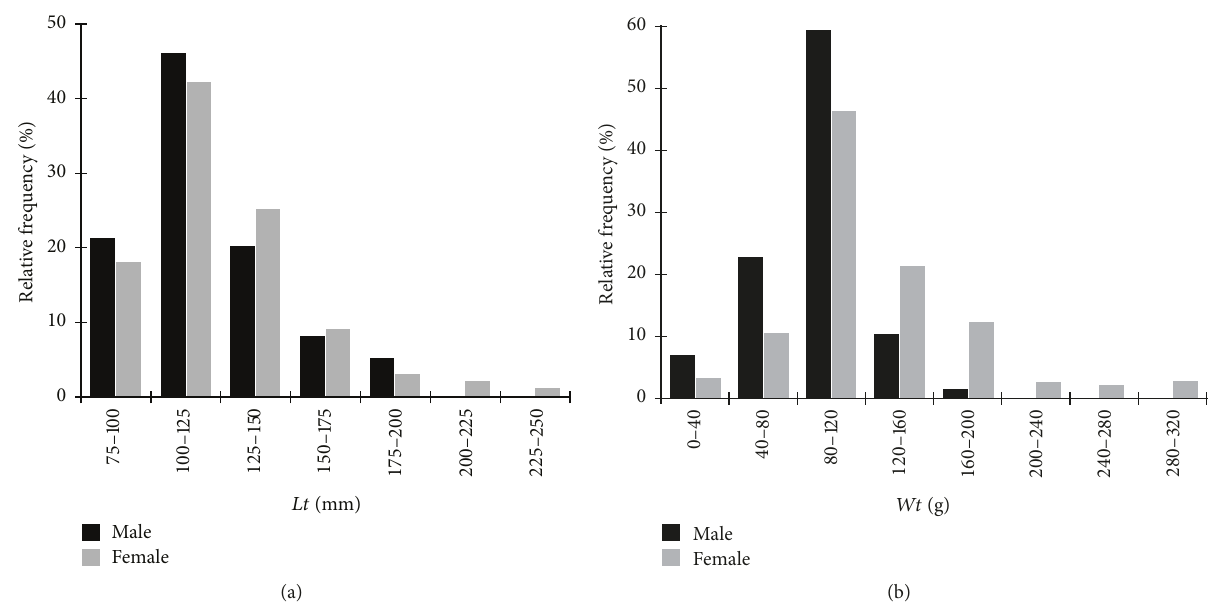
Figure 2: Population structure in total length (a) and weight (b) of S. gibbus in the Coaracy Nunes reservoir in Ferreira Gomes, Amap´a (Brazil).